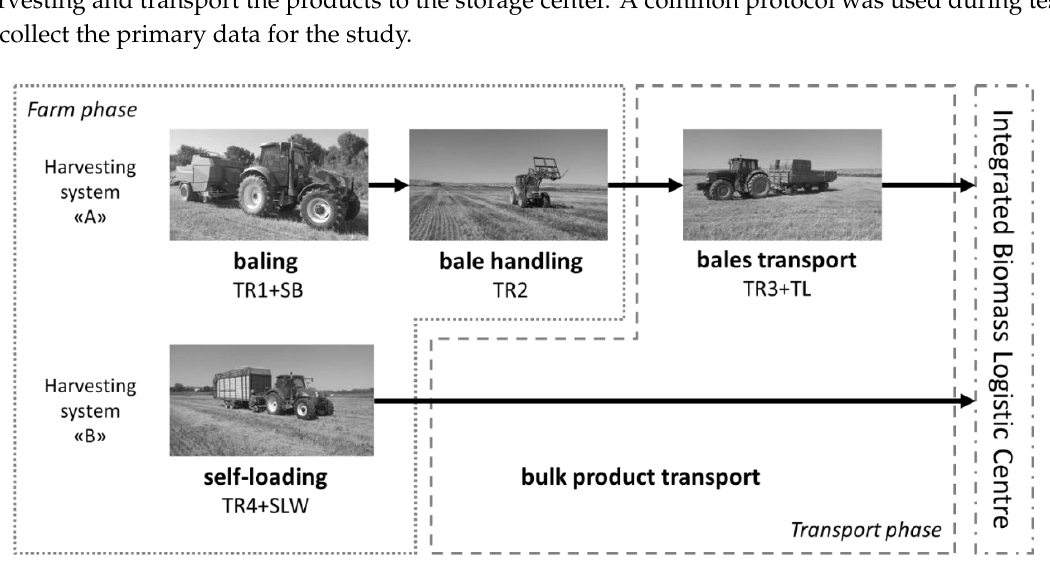
Figure 1. Scheme of the harvesting systems compared during the tests.